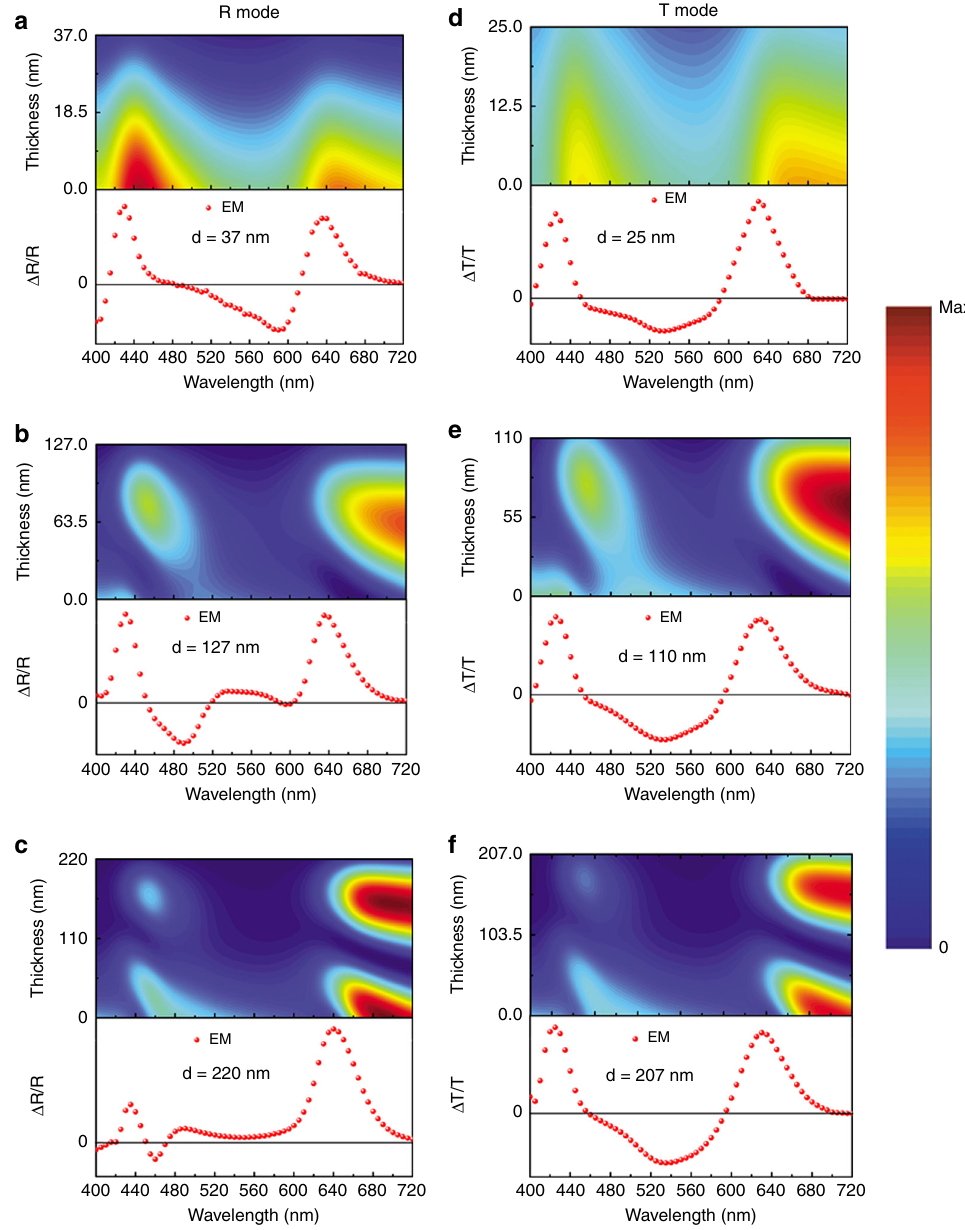
Fig. 6 Electromodulation spectra and optical fi eld distribution. a – c Re fl ection (R) mode. d – f Transmission (T) mode. The optical fi eld was calculated within the active layer. The scale bar on the right re fl ects the optical fi eld intensity which is in the same scale for all cases. The thickness here refers to thickness of the active layer used in the optical simulation. Note: The 0 nm corresponds to the position at the ITO/active layer interface and the maximum thickness value in each graph refers to the position at the active layer/metal